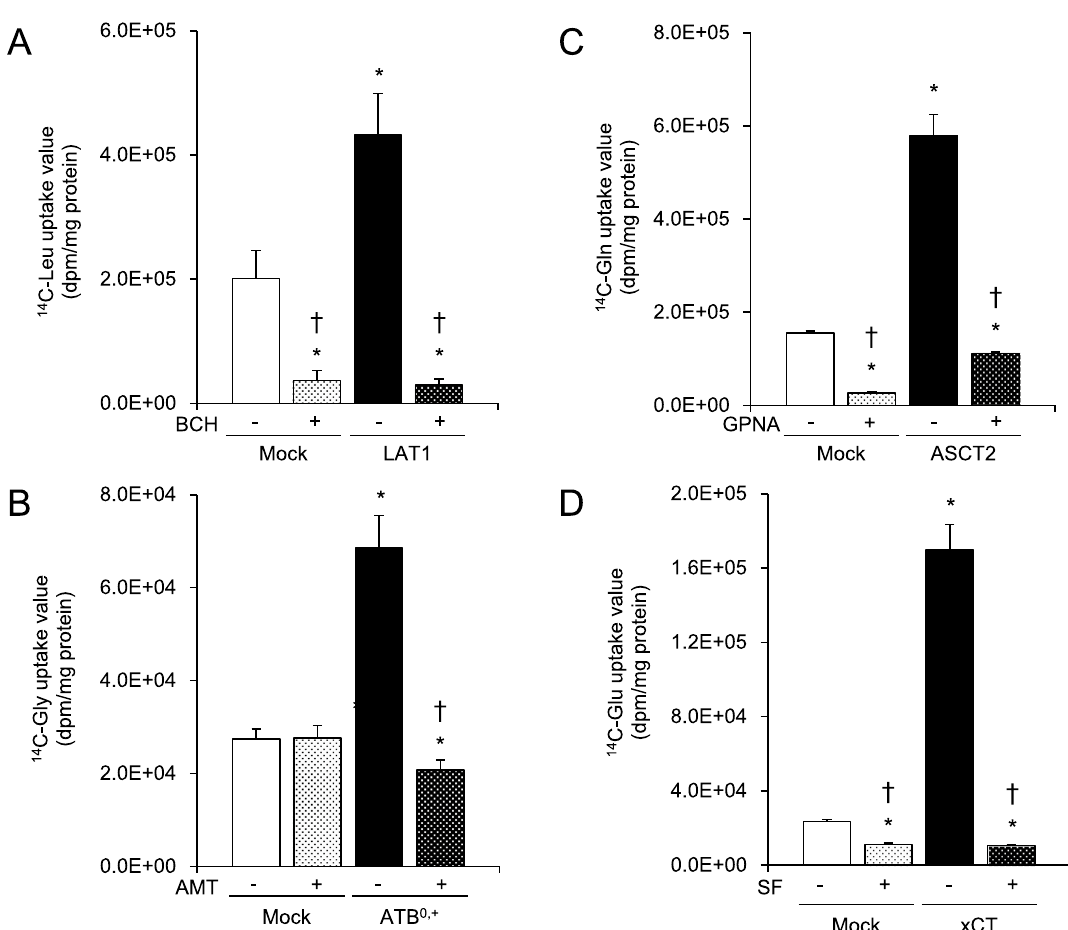
Fig. 4 Functional analysis of amino acid transporter-overexpressing cell lines. Transporter-mediated 14 C-labeled substrate uptake (1 µM) was measured in the presence ( ) or absence ( ) of specific inhibitors (BCH, AMT, GPNA, or SF) in control vector-transfected cells (Mock) and expression + − vector-transfected cells. Data are presented as the mean standard deviation ( n 4–6). * P < 0.01 when compared to Mock cells without an ± = inhibitor; † P < 0.01 when compared to the corresponding overexpressing cells without an inhibitor. AMT, α-Me-DL-Trp; BCH, 2-aminobicyclo-(2,2,1) -heptane-2-carboxylic acid; GPNA, L-γ-glutamyl-p-nitroanilide; SF,